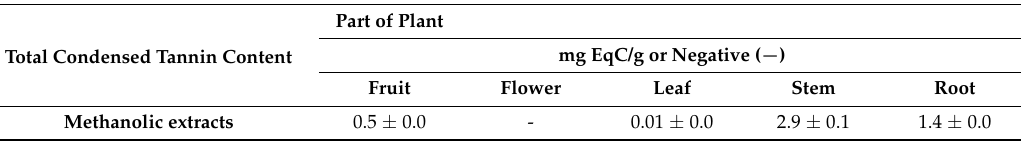
Table 1. Identification of the total condensed tannin content in different extracts of N. alba and ± standard deviation (mg C/g).